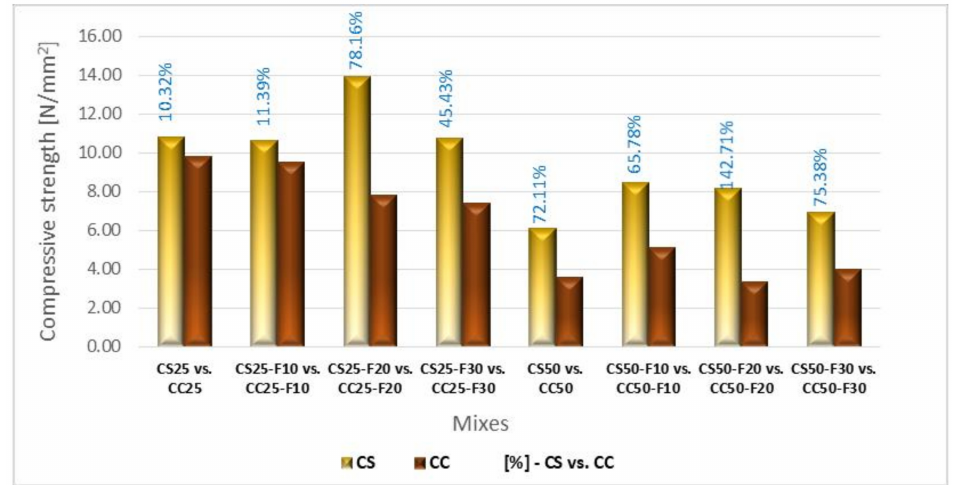
Figure 15. Compressive strength variation at the 28 days age of composites with sunflower stalks aggregates versus composites with corn cob aggregates [%].